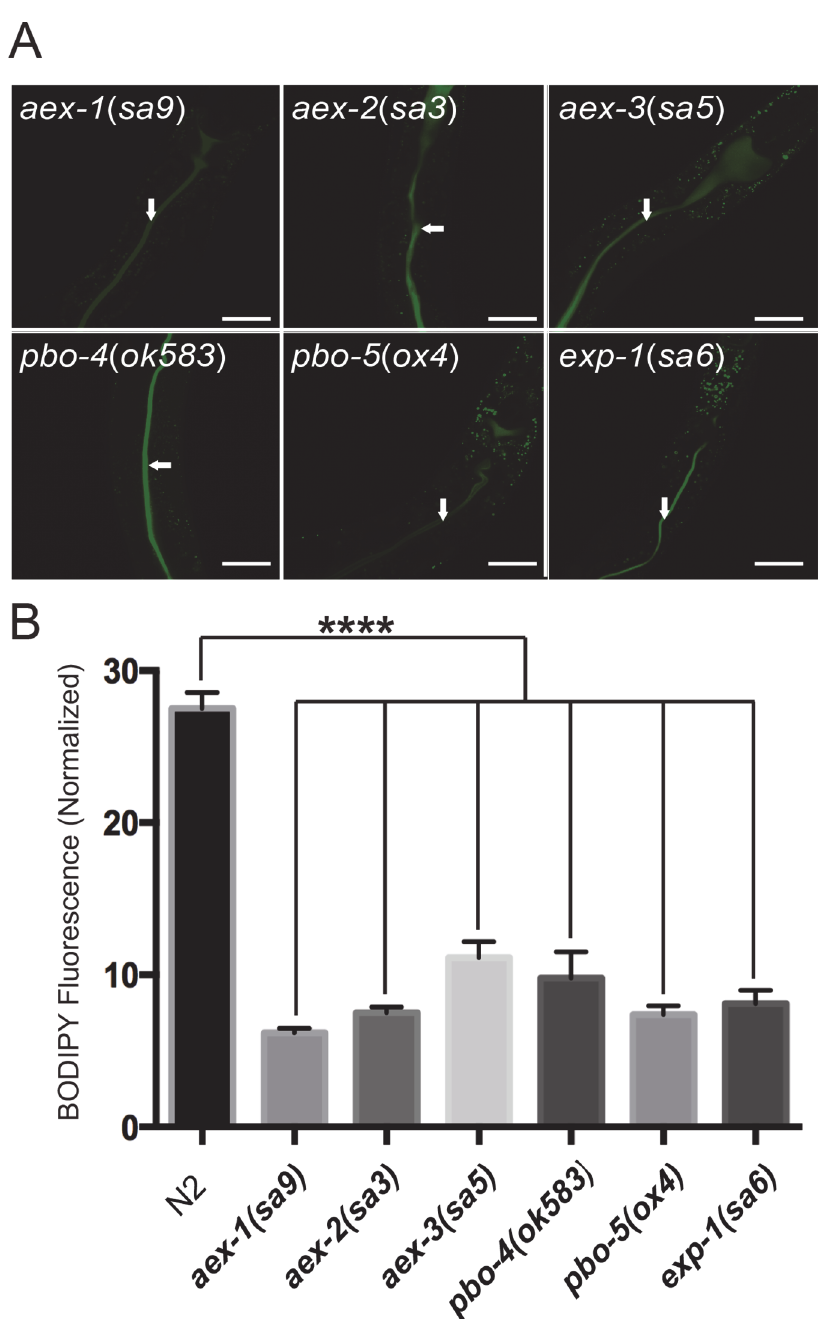
Fig 7. Other defecation mutants also display reduced uptake of C 1 -BODIPY 500/510 C 12 . A. Confocal fluorescence micrographs of worms fed the fluorescently labelled fatty acid derivative C 1 -BODIPY 500/510 C 12 . The arrows indicate the lumens of the intestine. In all panels, the anterior part of the intestine is up and (in most) slightly to the right. Scale bars are 40 μ m. B. Quantification of the uptake of the dye into the cytoplasm of intestinal cells (in arbitrary units). Error bars indicate standard errors of the means. **** indicates significant difference in the means determined by one-way ANOVA and Dunnett's multiple comparisons test ( σ =